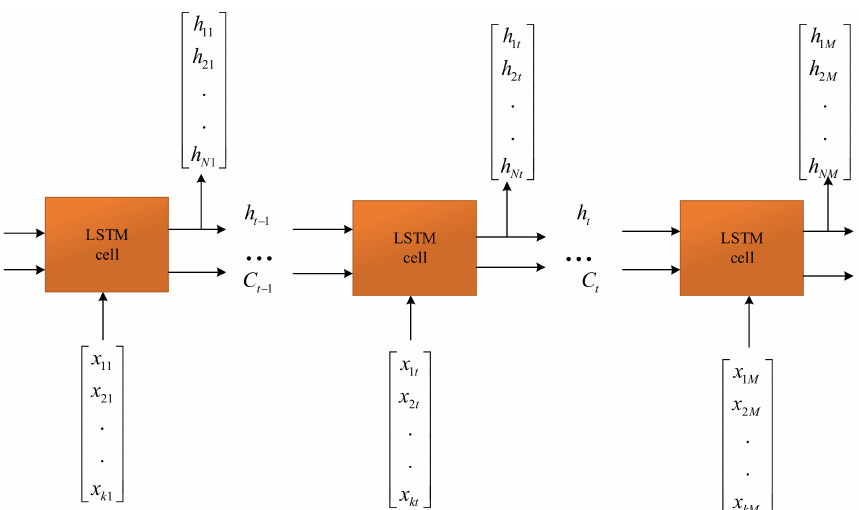
Figure 11. LSTM network